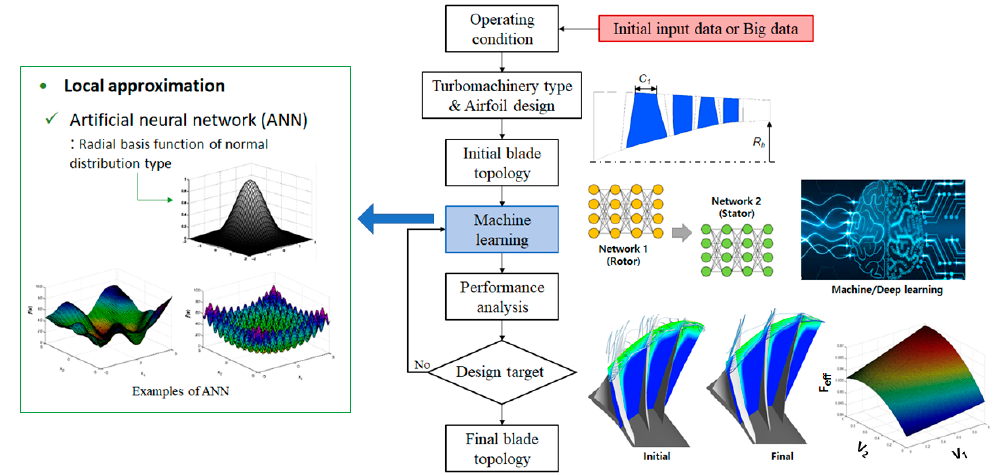
Figure 4. Procedure of the optimization design based on machine learning.